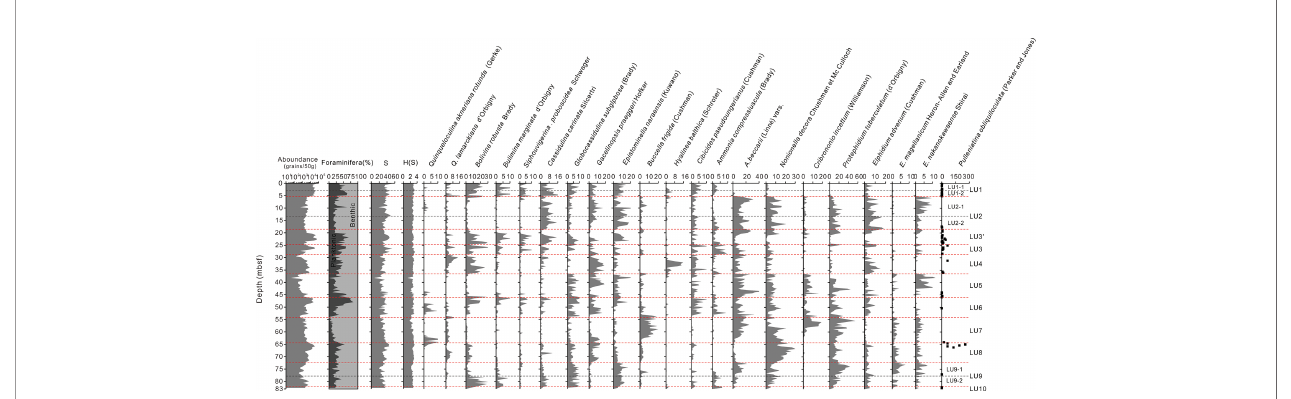
FIGURE 5 | Downcore pro fi les of foraminifera assemblage in borehole SFK-1. S: simple diversity; H(S): Shannon-Weiner index. H(S)= - S PilnPi (Pi refers to proportion of the i-th species). Pulleniatina obliquiloculata (Parker & Jones): numbers of fossils; the other foraminifera: volume